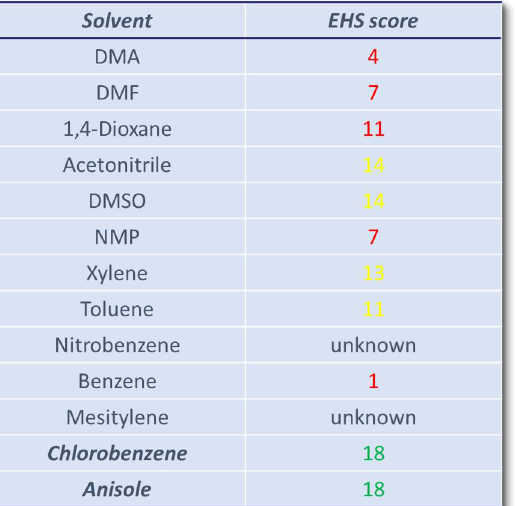
Figure 2. Summarized environmental, health, and safety (EHS) score data label [88,89]. Solvent raws have been color-coded using a traffic light metric: green = recommended (few issues), yellow = problematic (some issues), red = hazardous (major issues). The higher the score, the more favorable the EHS profile of the solvent.